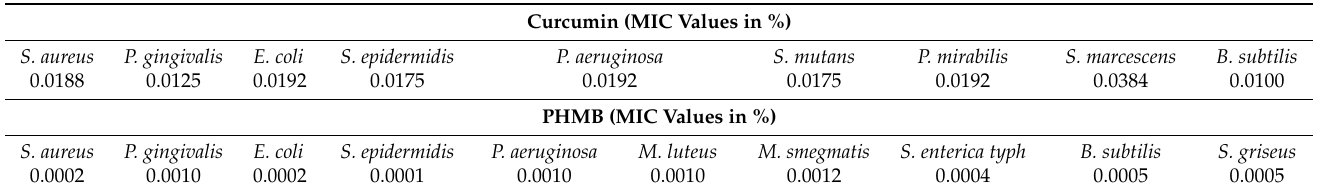
Table 1. Minimum inhibitory concentration (MIC) of curcumin and PHMB on various species of bacteria